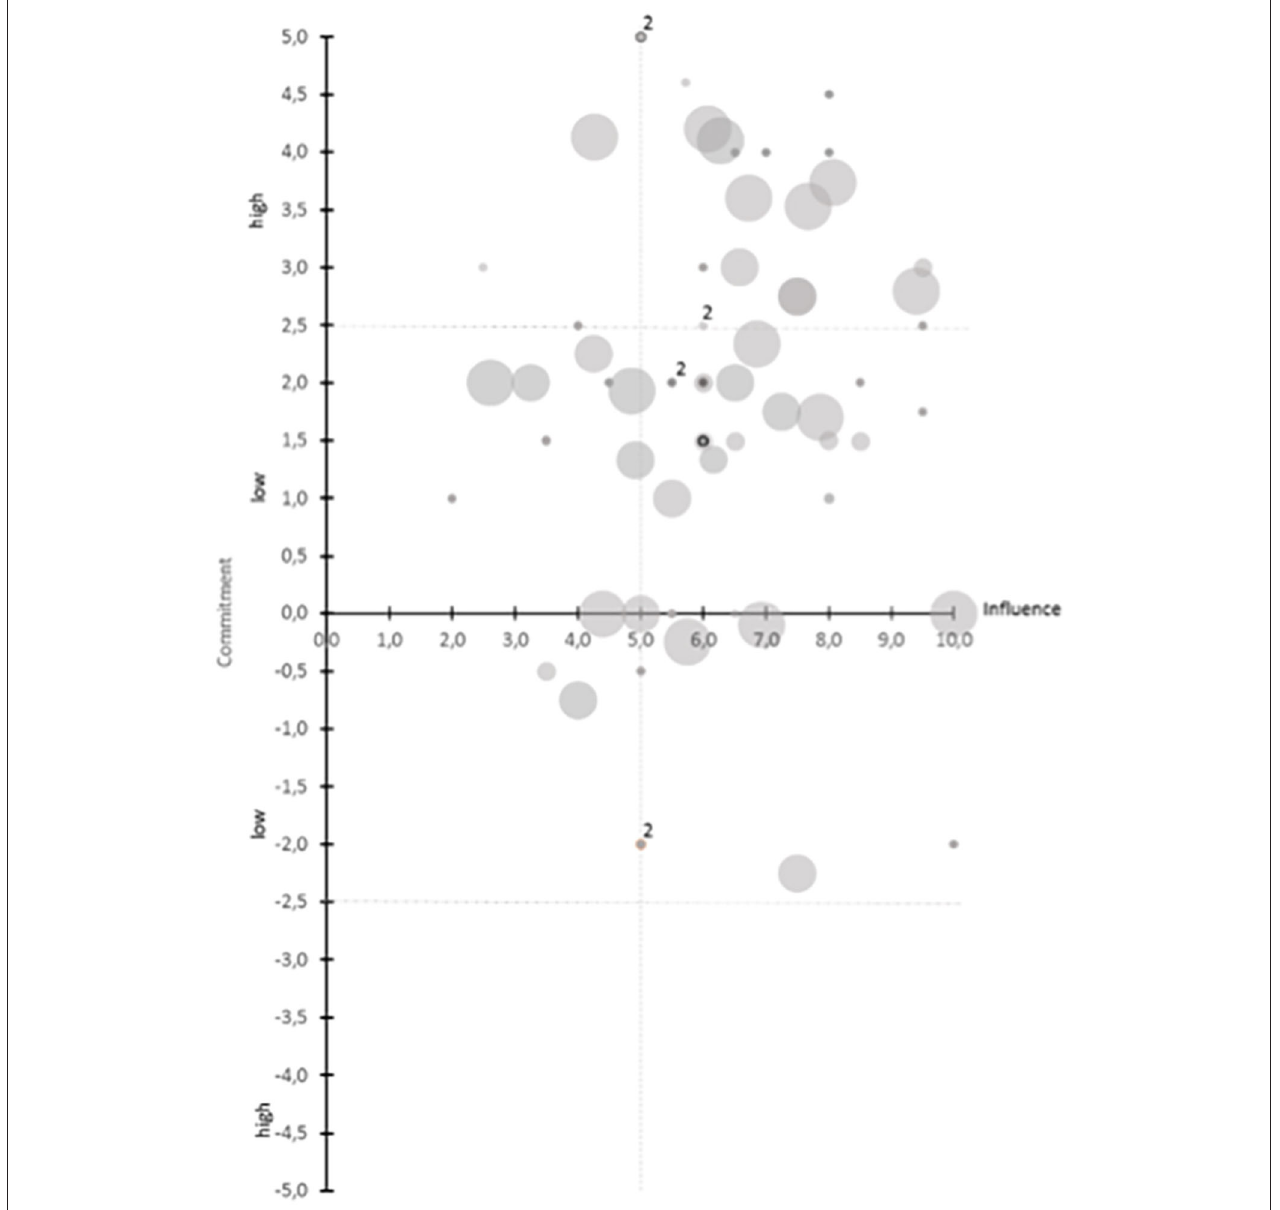
FIGURE 2 | Results from the power/interest matrix (9) analysis condensed from feedbacks from 5 experts from the study core group of the current project. As may be seen from the figure, the method allowed analysis of individual commitments of different regional stakeholders and their effective influence on the development of an active and healthy aging region (HAR). This approach also allows to construct a taxonomy of regional stakeholders as primary “framework” of an ecosystem toward a HAR, not considering communication pathways at this point of the process